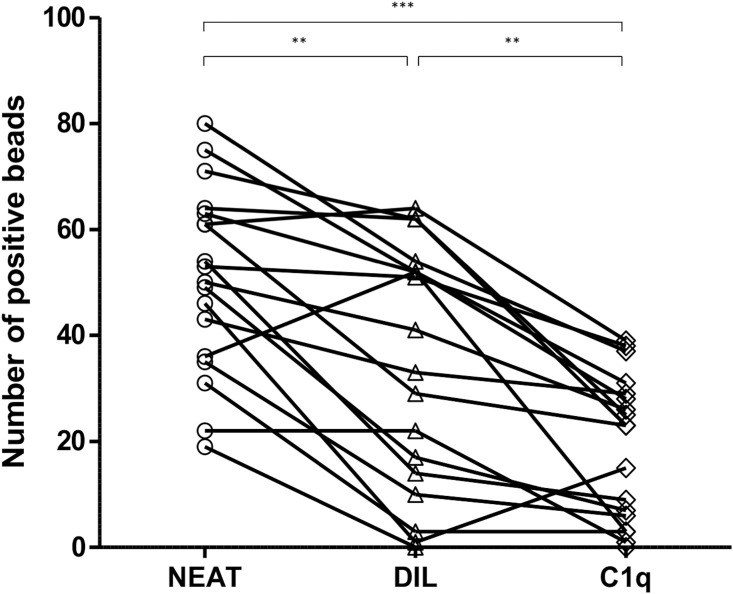
Number of positive beads after study of neat, diluted serum and C1q in highly-sensitized patients.The number of positive beads in 18 highly sensitized patients are depicted after Single Antigen anti-HLA class-I test in neat serum (neat, open circles), in 1/160 diluted serum (DIL, open triangles) and after C1q test (C1q, open diamonds) using the cut off value described in Material and Methods section. Differences of the medians were assessed by Wilcoxon test, (**, p<0.01; ***.p<0.001).